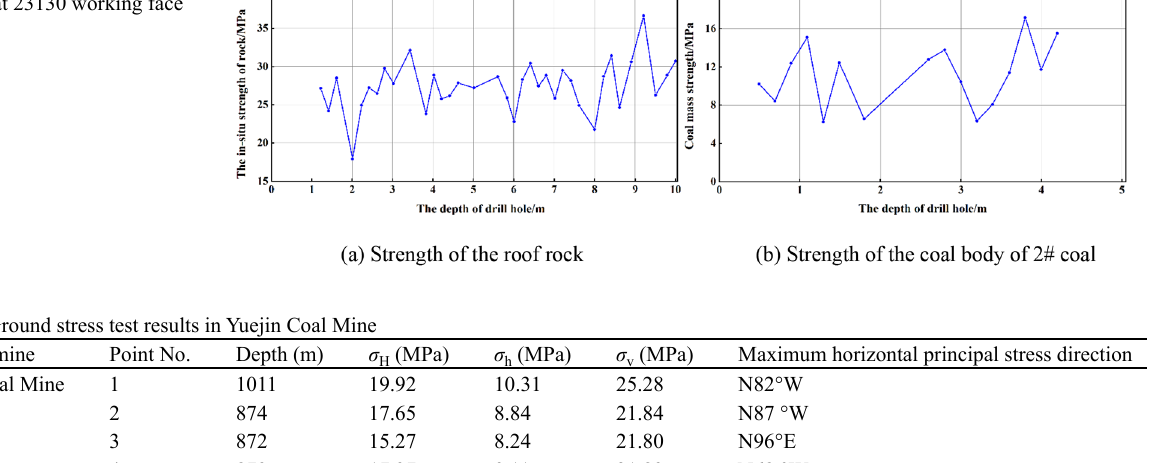
Fig. 3 Strength test curve of coal and rock at 23130 working